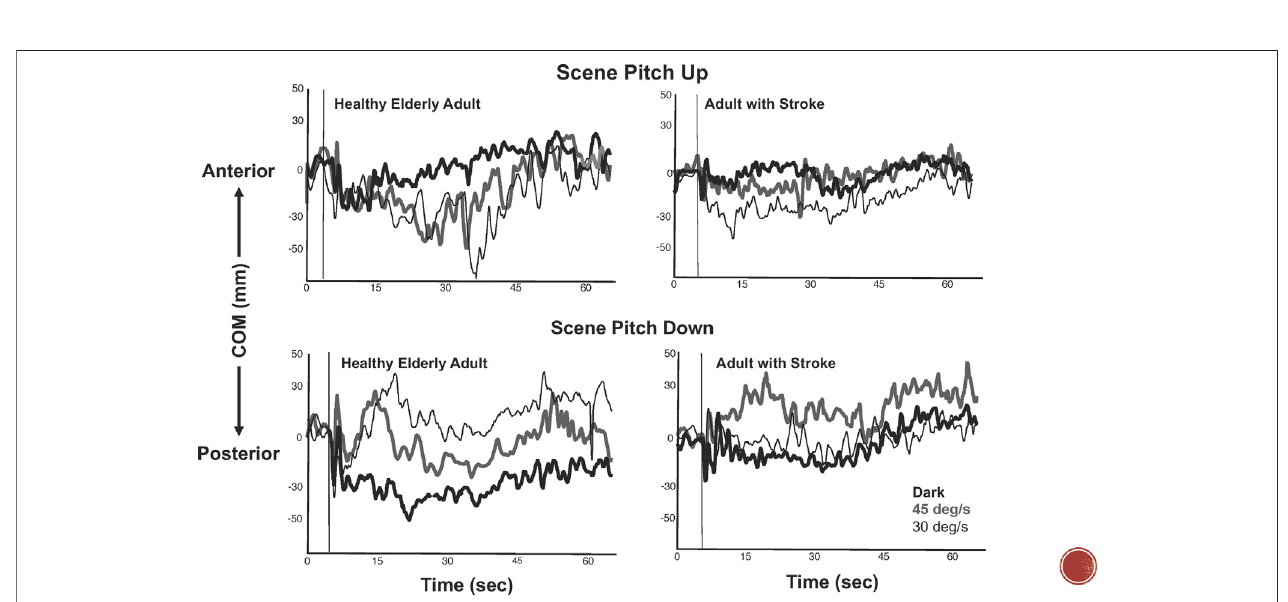
FIGURE 2 | Center of mass (COM) excursions during a-p translations of a platform at 0.25 Hz while standing in the dark (bold black line) and while viewing continuous pitch rotations of optic fl ow at 30 deg/sec (thin black line) and 45 deg/sec (bold gray line). Top graphs: responses to pitch-up rotations of the scene in a healthy 62-year-old adult (left) and 65 year-old-adult with right hemiplegia (right) . Bottom graphs: responses to pitch down rotations of the scene in a healthy elderly adult (left) and elderly adult with stroke (right) . Vertical thin line indicates start of optic fl ow fi eld.